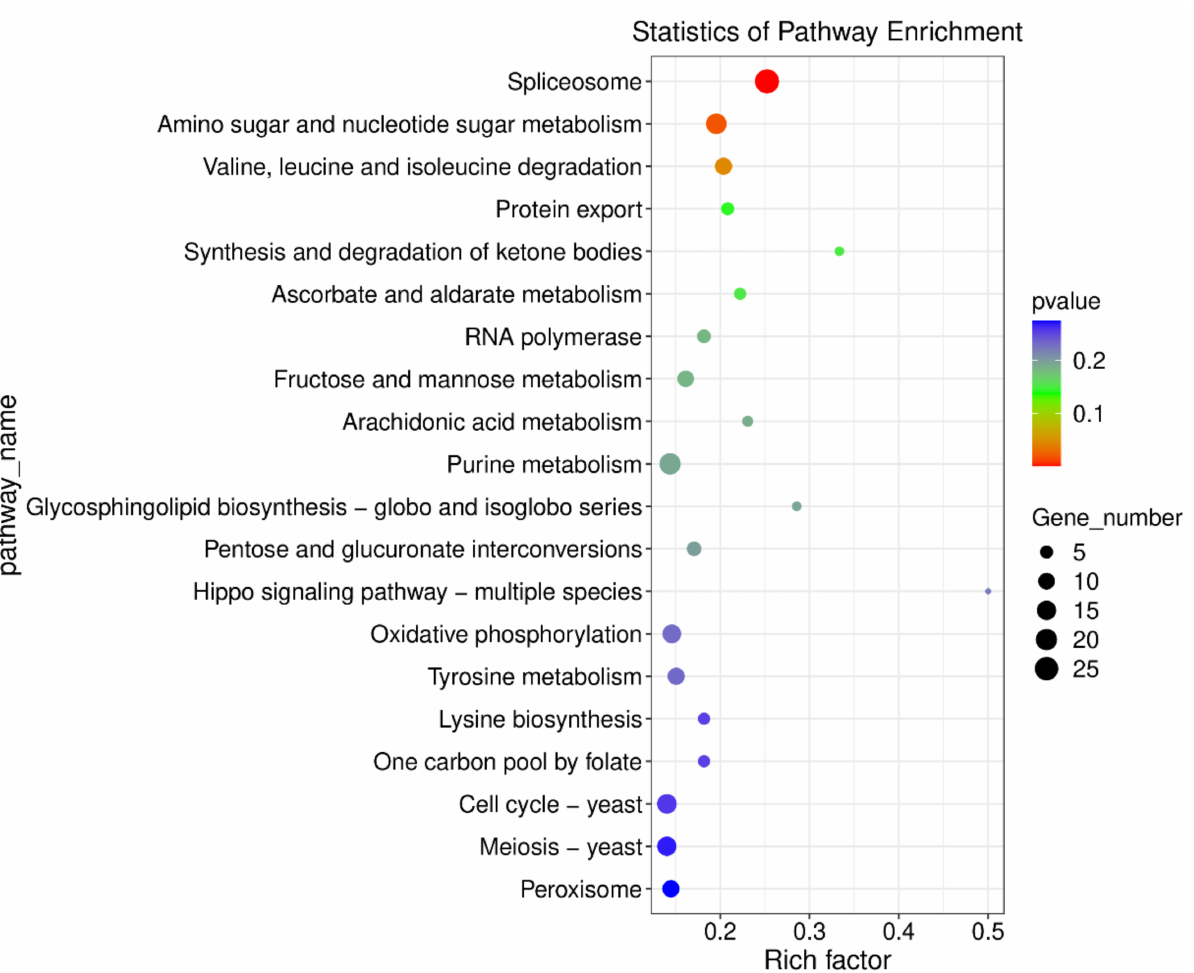
Figure 8. KEGG enrichment scatter plot. The ordinate represents the KEGG pathway, the abscissa represents the Rich factor. The larger the Rich factor, the greater the enrichment. The larger the point, the greater the number of differential genes enriched in the pathway. The redder the color of the dots, the more significant the enrichment.